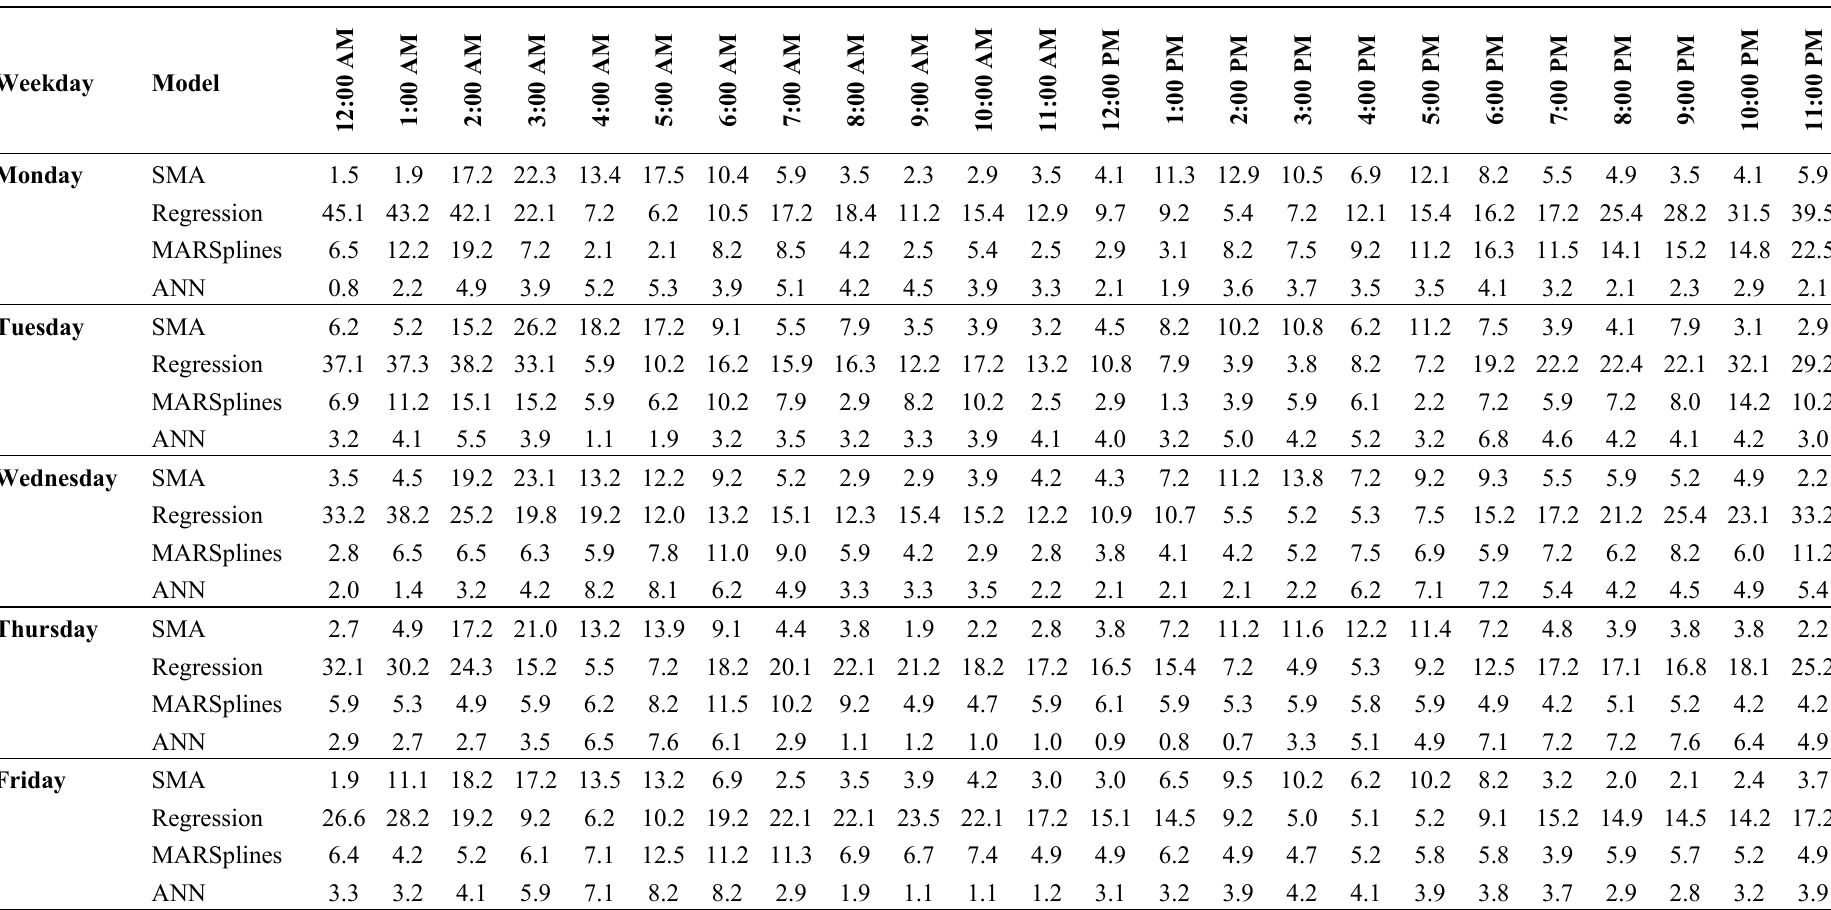
Table 2. Sixty-minute forecast errors (%) of electrical kW demand vs.